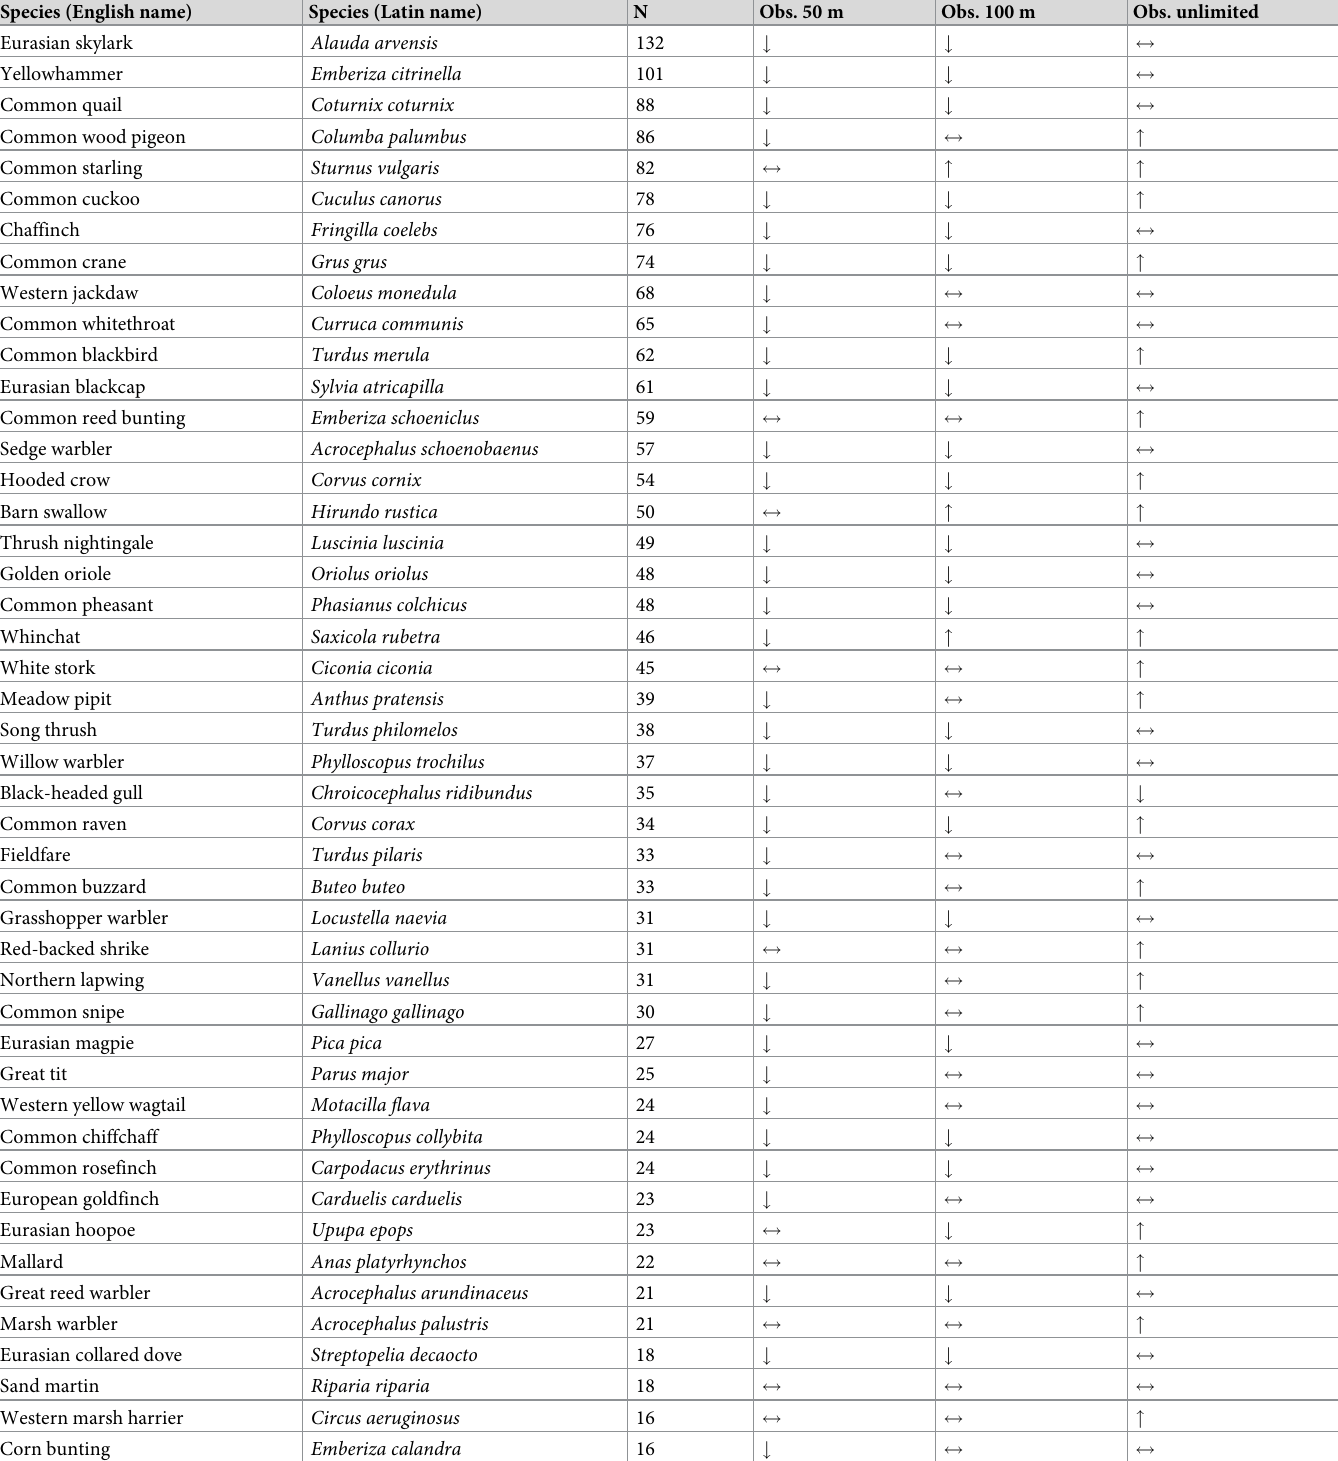
Table 2. Results of Wilcoxon two-related samples tests examining differences in detection rate of the most common bird species by recorders and observers survey- ing birds within 50 m (Obs. 50 m), 100 m (Obs. 100 m) and unlimited radius (Obs. unlimited). Species (English